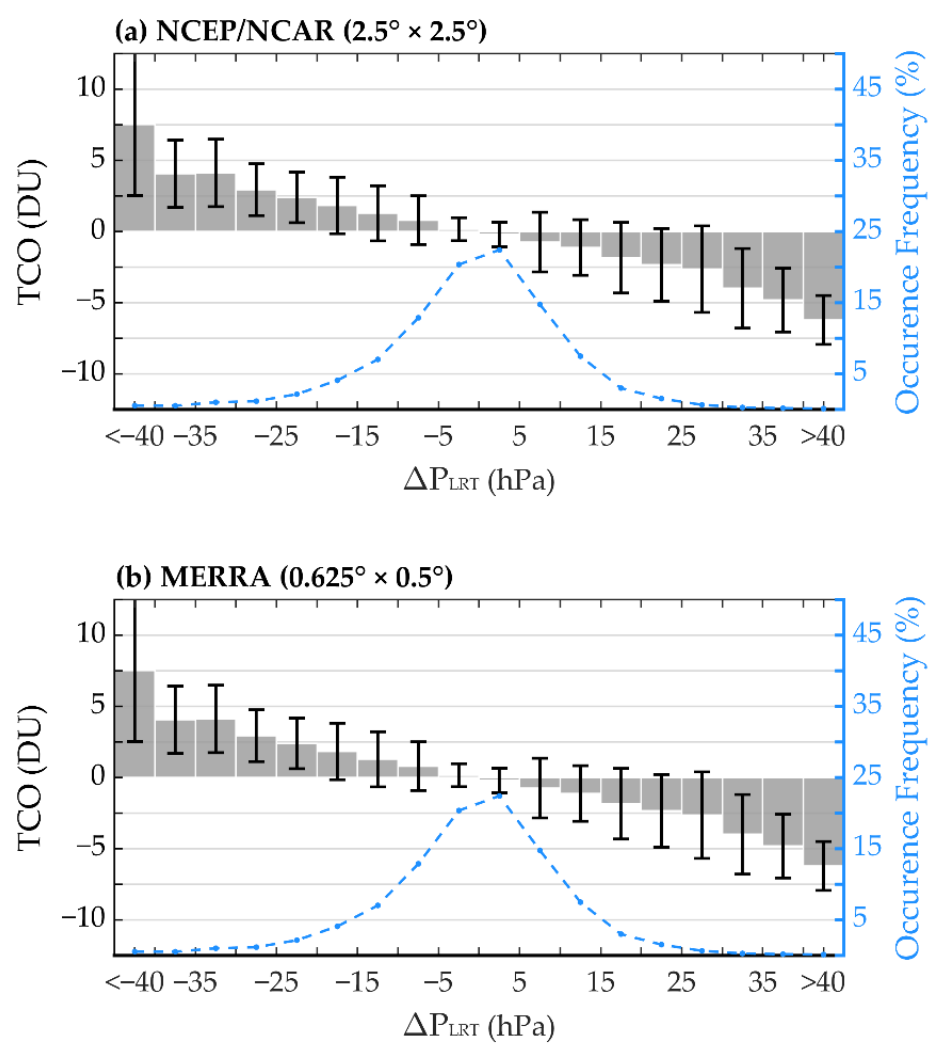
Figure 7. ( a ) Means (gray bar) and standard deviations (black error bar) of tropospheric column ozone (TCO) biases caused by using NCEP/NCAR P LRT in each of the P LRT bias intervals (left y -axis), based on all monthly samples for which both radiosonde and ozonesonde are available. TCO bias is computed as the difference in TCO using NCEP/NCAR P LRT and using radiosonde P LRT . The occurrence frequency of the NCEP/NCAR P LRT biases in each of the P LRT bias intervals is also shown (blue dashed line, right y -axis). ( b ) The same as ( a ), but for P LRT biases in MERRA-2 and induced TCO biases. The NCEP/NCAR and MERRA-2 data are used in their original resolutions of 2.5 ◦ × 2.5 ◦ and 0.625 ◦ × 0.5 ◦ in longitude and latitude. The global distribution of TCO biases (Figure 8) is basically similar to that of P LRT biases (Figure 2), including the latitudinal behavior. Negative biases in TCO prevail in the tropics and the high-latitudes of the NH, with means less than 1 DU in magnitude. TCO in the subtropics is overestimated and the positive TCO biases peak around 30 ◦ –40 ◦ in each hemisphere with values of ~1.5–3.5 DU, corresponding to P LRT biases varying from − 8 to − 14 hPa (Figure 2). For some grid cells in the subtropics, the positive TCO bias even reaches 4 DU or more, corresponding to a negative P LRT bias less than − 20 hPa. For the NCEP/NCAR, the overestimation of TCO reaches ~3.5 DU around 70 ◦ –80 ◦ S, because the extreme P LRT biases (about − 20 hPa) appear there. Overall, the globally averaged bias in TCO due to use of the reanalysis P LRT is 0.64 DU in NCEP/NCAR and 0.28 DU in MERRA-2, corresponding to 2.2% and 1.1% of average TCO values, respectively. Note